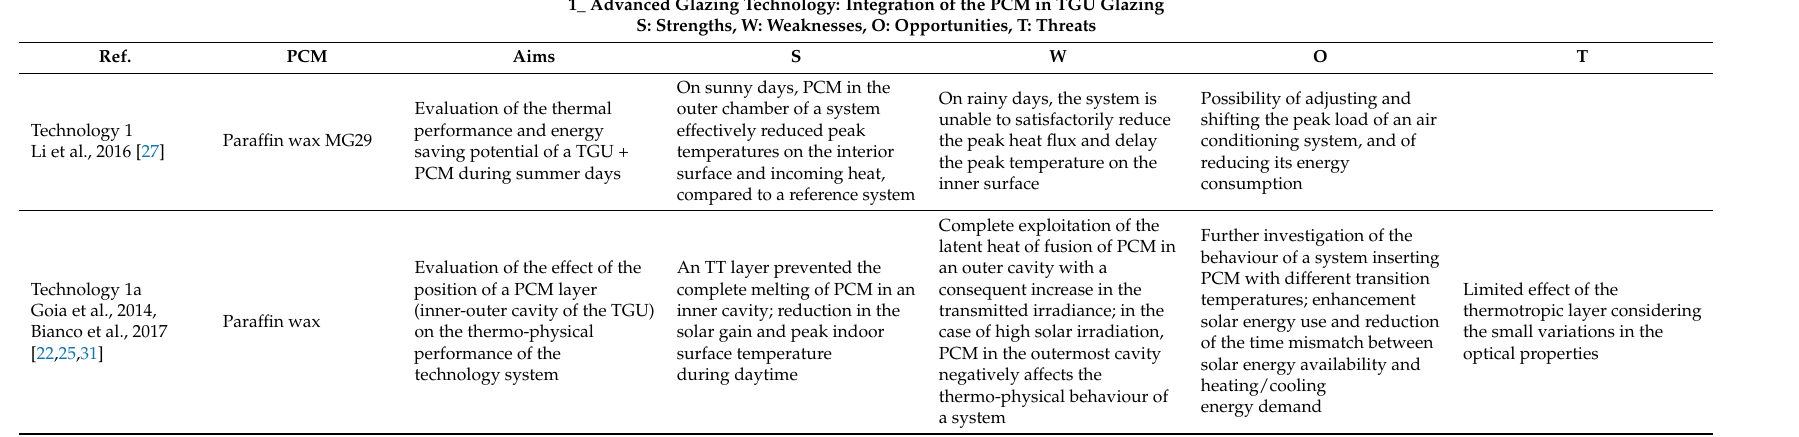
Table 3. SWOT analysis of PCM in TGU